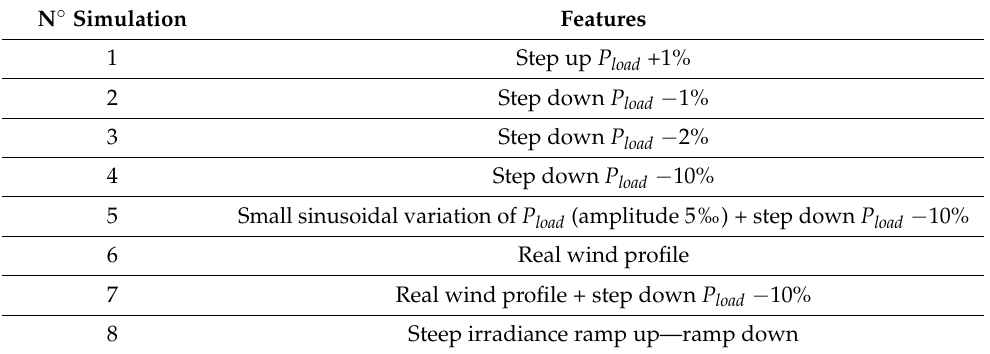
Table 3. Summary of Simulation 1–8.